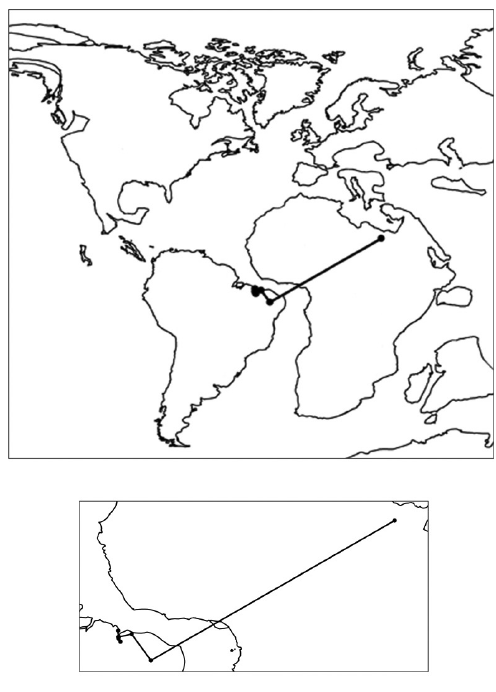
Fig. 7 - kimmeridgian paleogeographic map showing the indi- vidual track of Rhipis sp., with a zoom of the occurrences below.